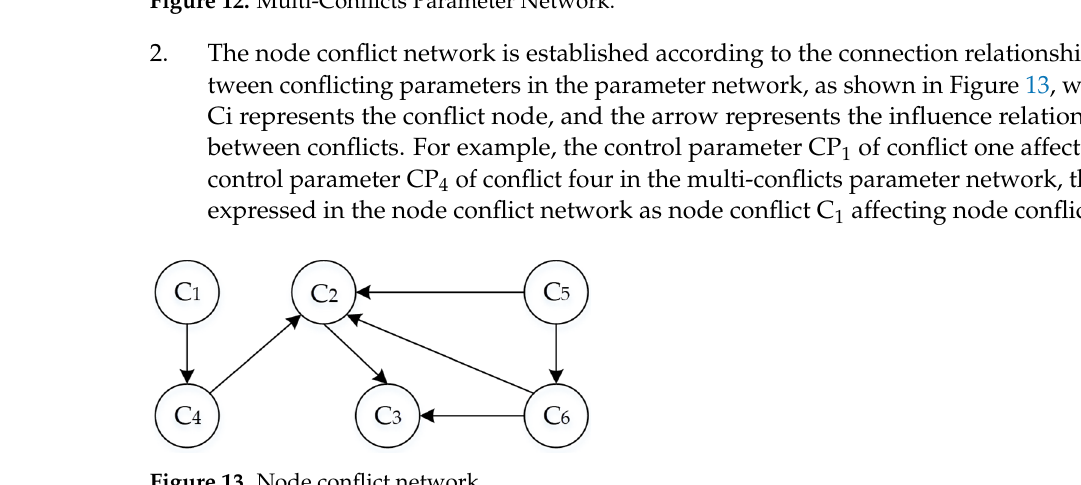
Figure 13. Node conflict network.